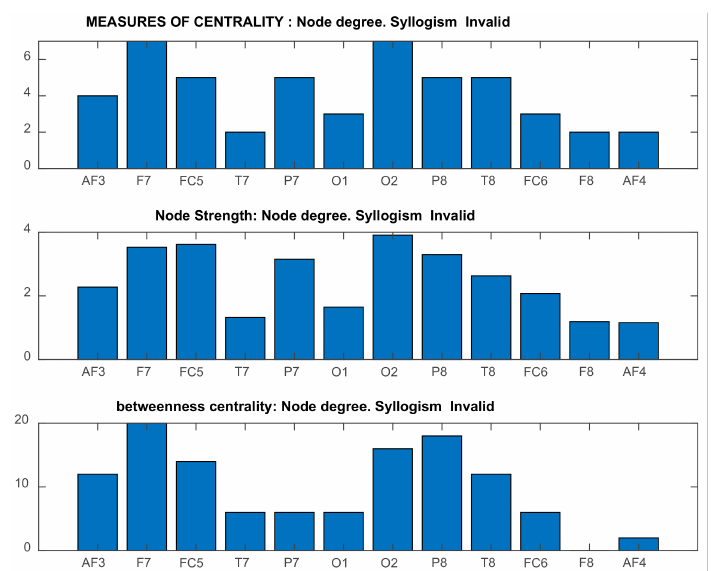
Figure 26. Measures of centrality of the network generated by the brain salience matrix V, for the invalid syllogism. The rows and columns of V are the nodes of the network, while the links correspond to elements of the weight matrix W (normalized V and taking its elements with a threshold = 0.20, i.e., retaining the 20% of the strongest links).